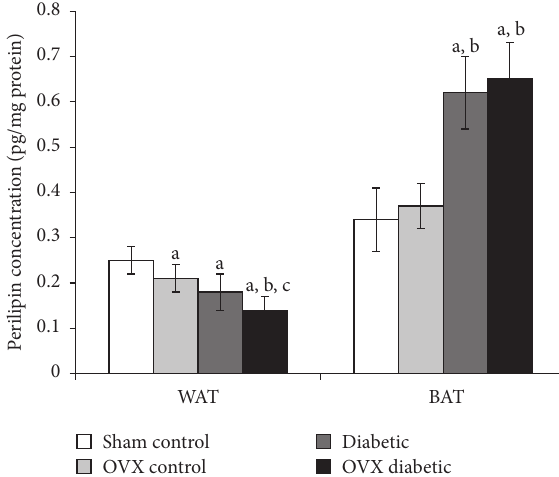
Figure 1: Perilipin level (pg/mg protein) in white and brown adipose tissues of different studied groups at the end of the